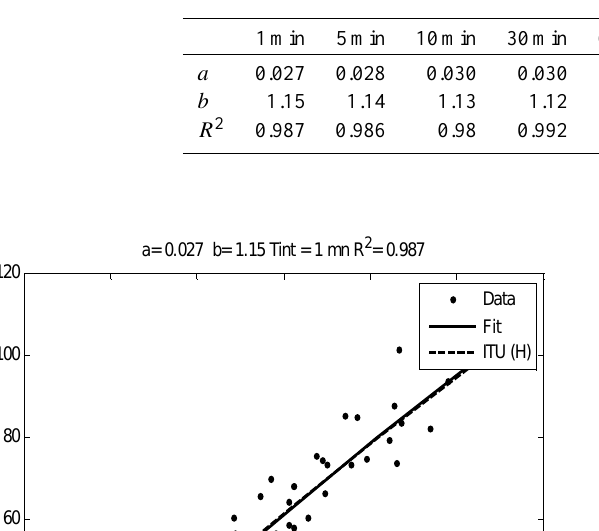
Fig. 2. Error induced on the rain estimation when the ITU power law is used for an integration time equal to 5 min. For each rain bin, the box-and-whiskers diagram indicates the median (central vertical line), and the lower and upper quartiles (left and right edges of the box). The whiskers indicate the lower and upper limits of the distribution, within 1.5 times the interquartile range, from the lower and upper quartiles, respectively.